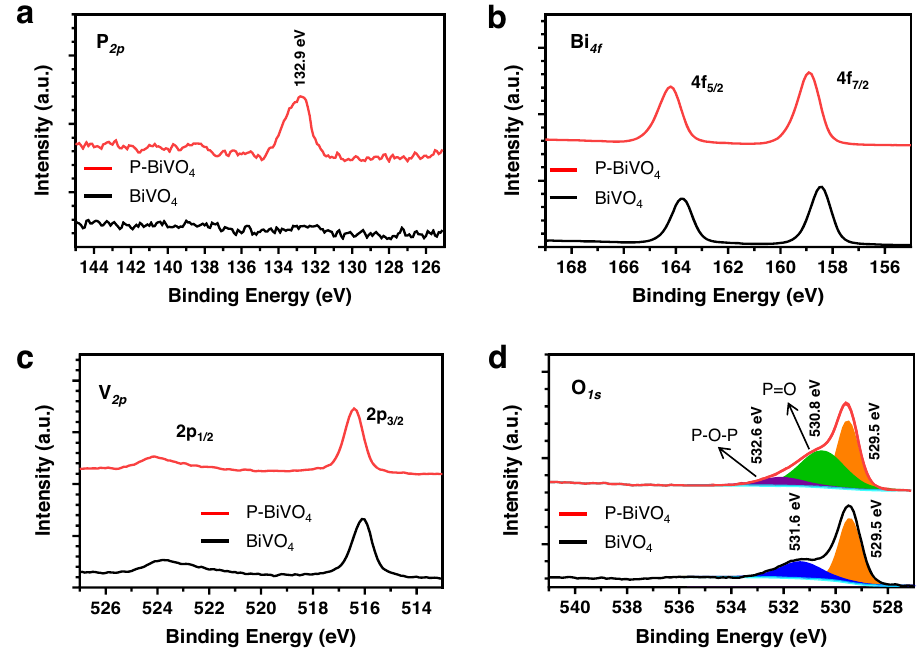
Fig. 2 | Electronic structure characterizations. a P 2p, b Bi 4f, c V 2p, and d O 1s XPS spectra of the BiVO 4 and phosphorus-doped BiVO 4 samples (P-BiVO 4